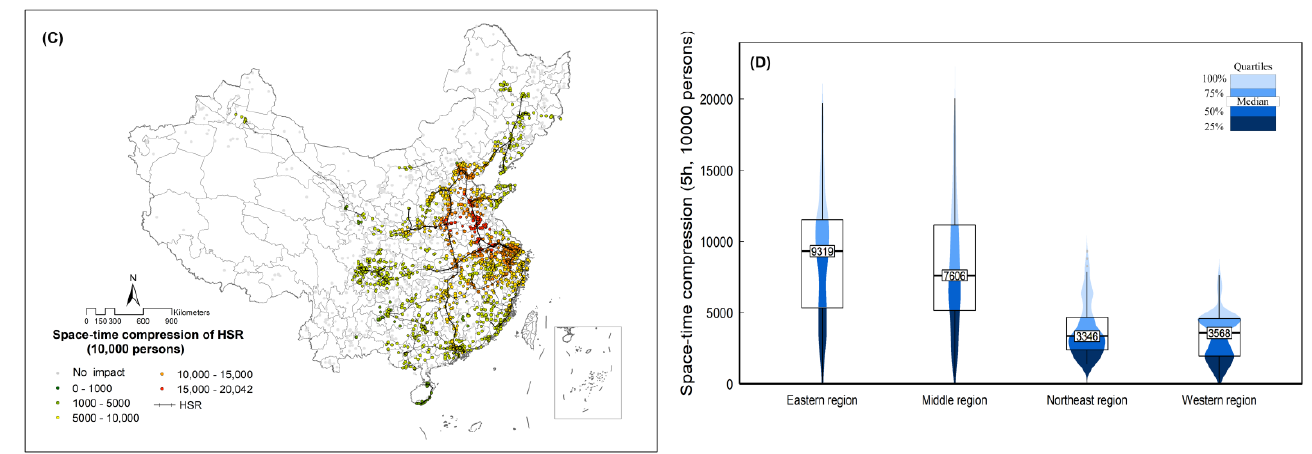
Figure 3. TSC effect of HSR on tourist destinations. ( A – C ) represent the TSC effect under temporal distance of 3 h, 4 h and 5 h respectively during 2008–2019. ( D ) shows the Violin Plot of TSC effect of HSR in four regions of China (5 h).